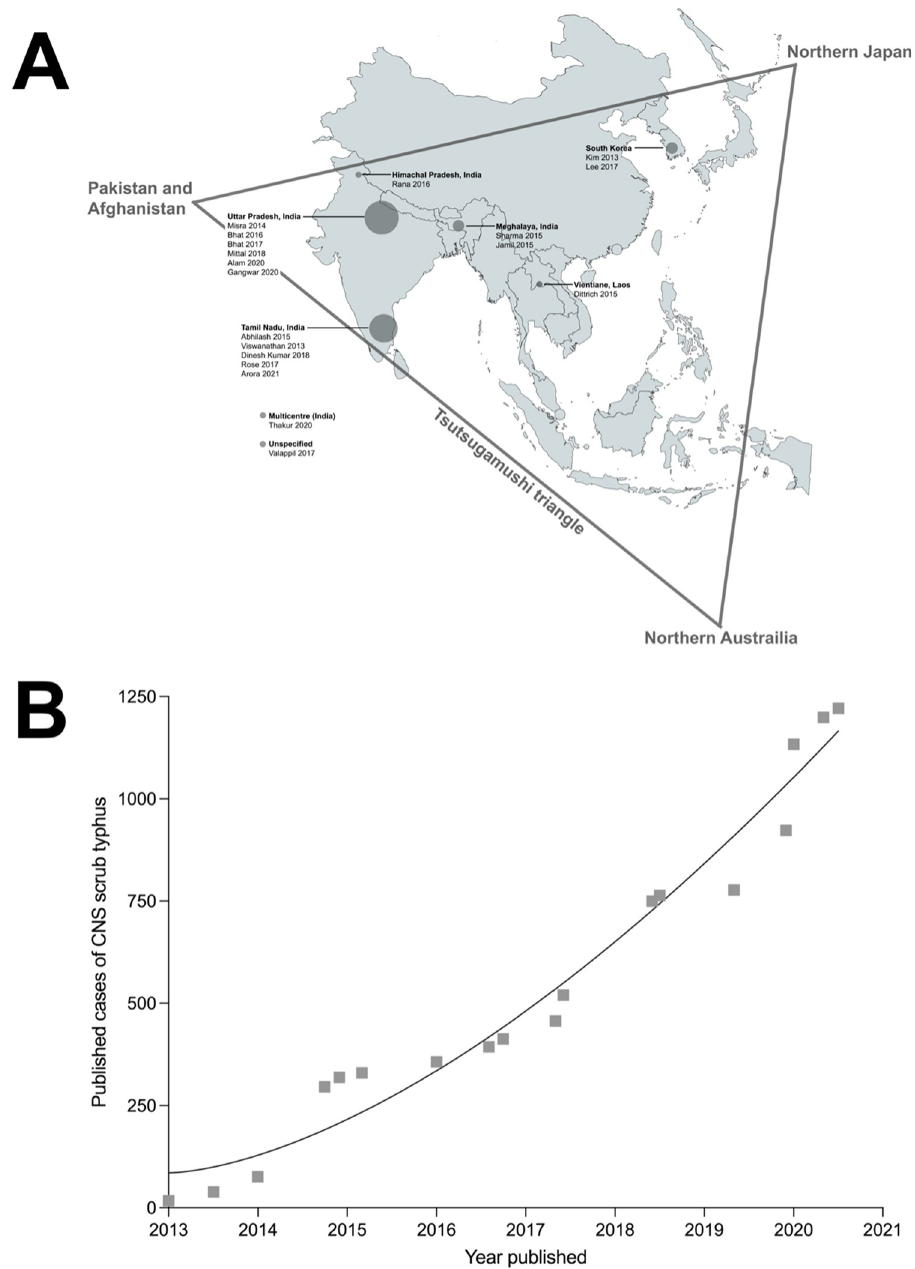
Fig 4. A: Map illustrating tsustugamushi triangle and the included studies in our meta-analyses, circles are proportionate to the size of the cohorts. The map was created using public domain image (https://commons. wikimedia.org/wiki/File:BlankMap-World.svg). B: Graph illustrating number of published cases of central nervous system (CNS) scrub typhus described in literature.